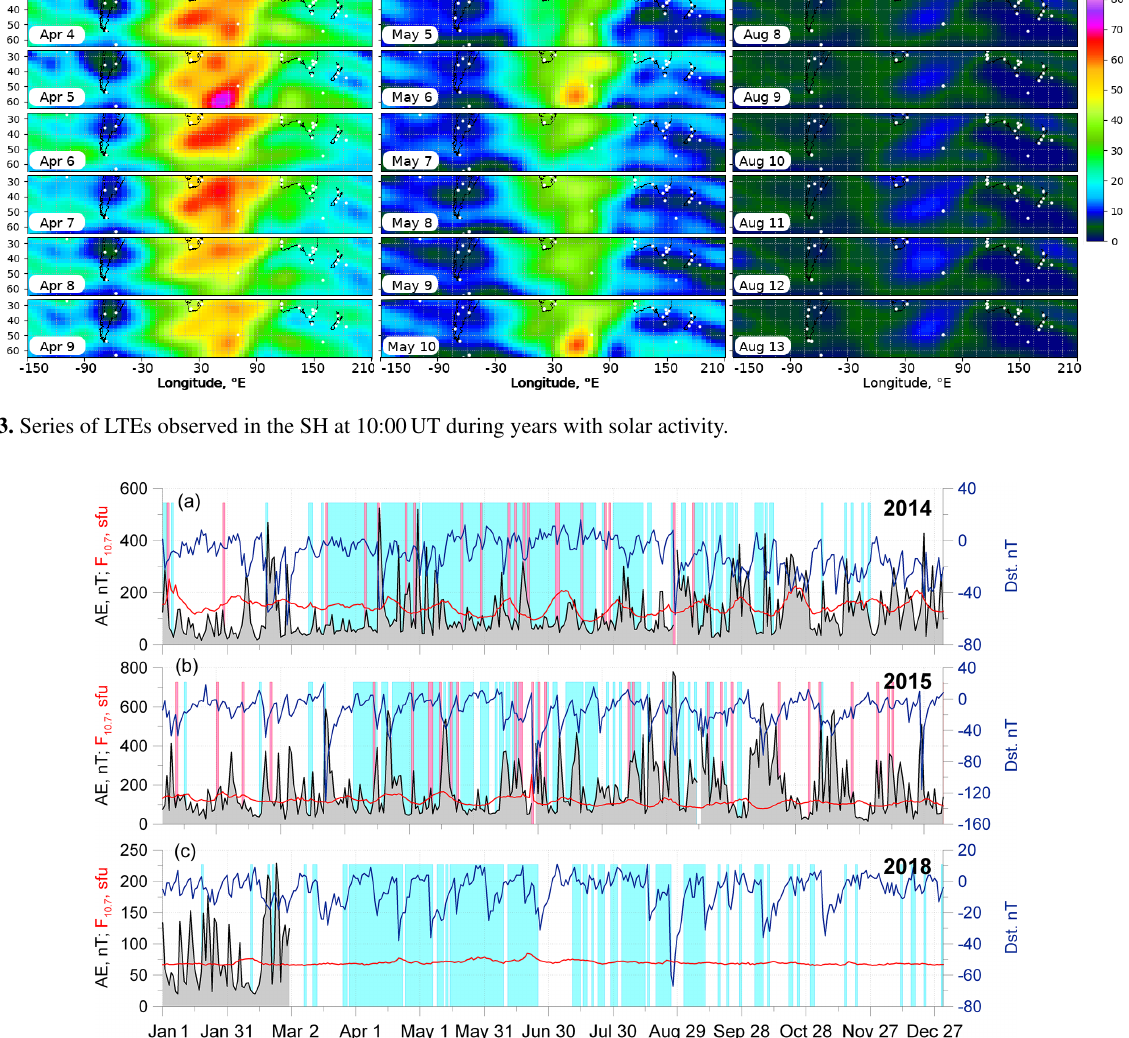
Figure 4. Days with LTEs observed in the SH (blue bars) during 2014 (a) , 2015 (b) and 2018 (c) . Plots show the annual variations in the daily average F10.7 (red line), AE (black line with gray shading) and Dst (navy blue line) indices values. Cases of bright SLTE observations are highlighted using red bars. In 2018, the AE index was only available for January and